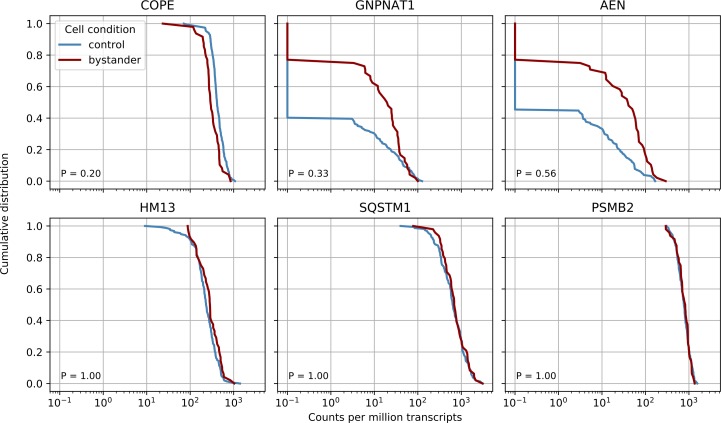
Bystander effects are not significant but suggestive for the COPE gene.We compared control cells with cells from infected cultures but which had zero viral reads themselves (‘bystander cells’), from the earliest two time points (4 and 12 hr post-infection - in later cultures almost all cells had virus reads). We performed nonparametric Kolmogorov-Smirnov test on gene expression to detect differentially expressed genes in bystanders and found no significant result after Bonferroni correction, however the three most significant genes are plotted together with two ‘time switchers’ (HM13 and SQSTM1) and one control gene. The P value of the statistical test is shown in the bottom left corner of each plot. Whereas the other two time switchers show no difference, COPE may to be downregulated in bystander cells.